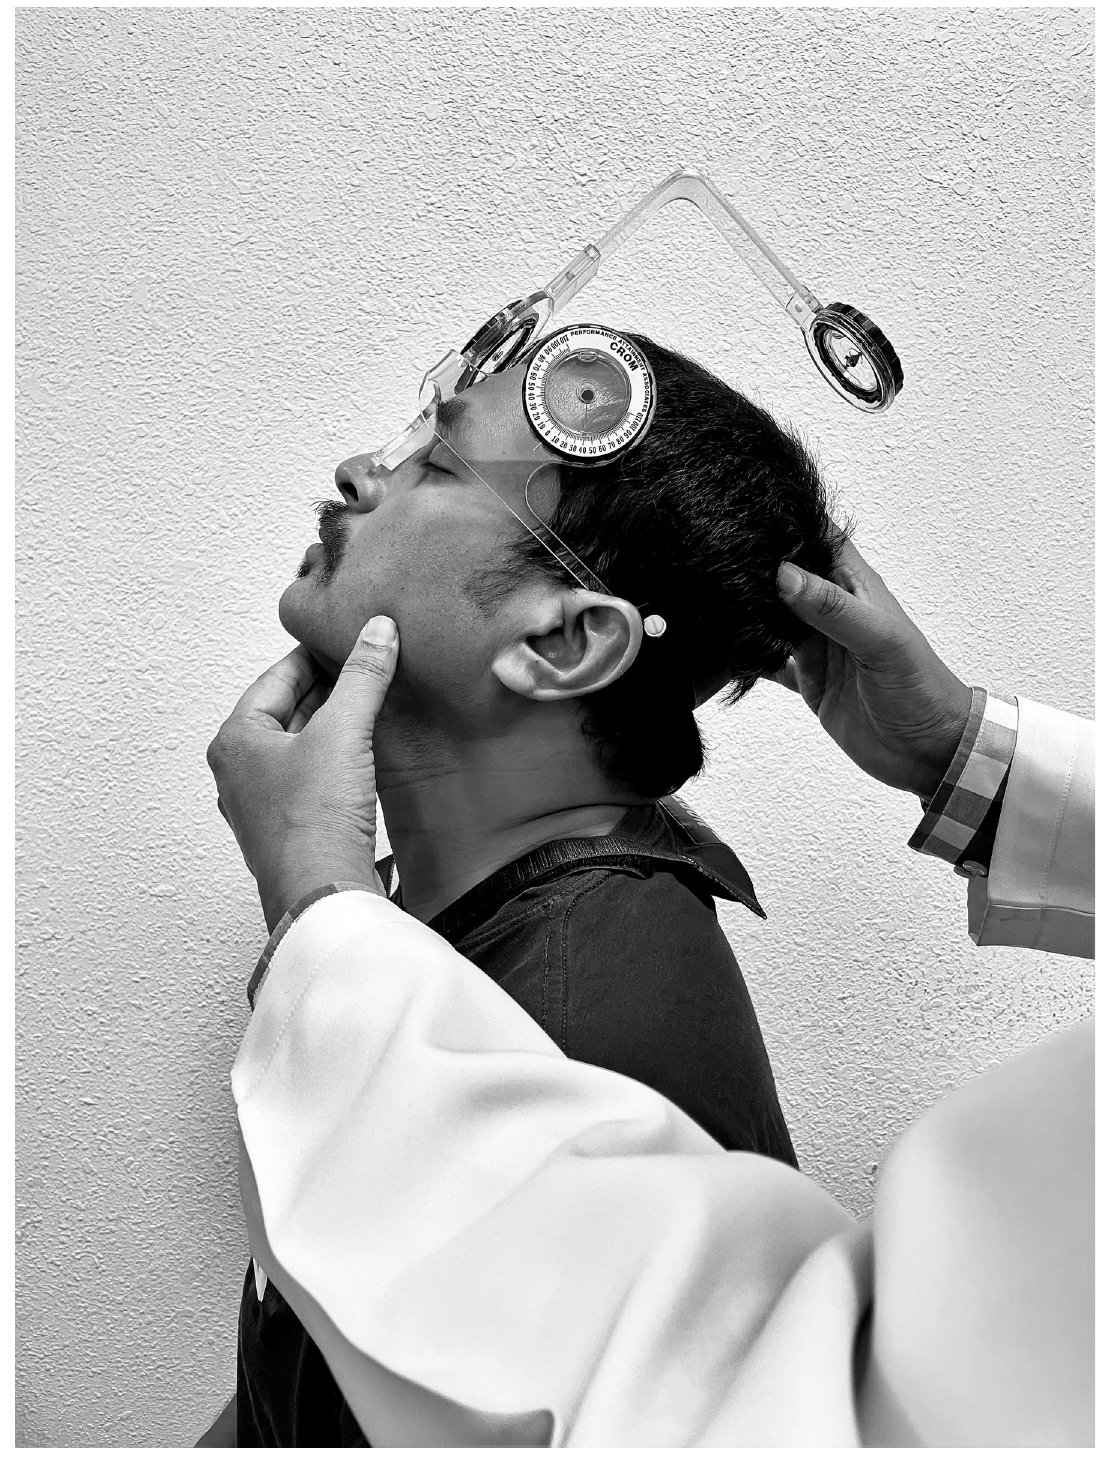
Fig 1. Cervical proprioception assessment using a cervical range of motion device.